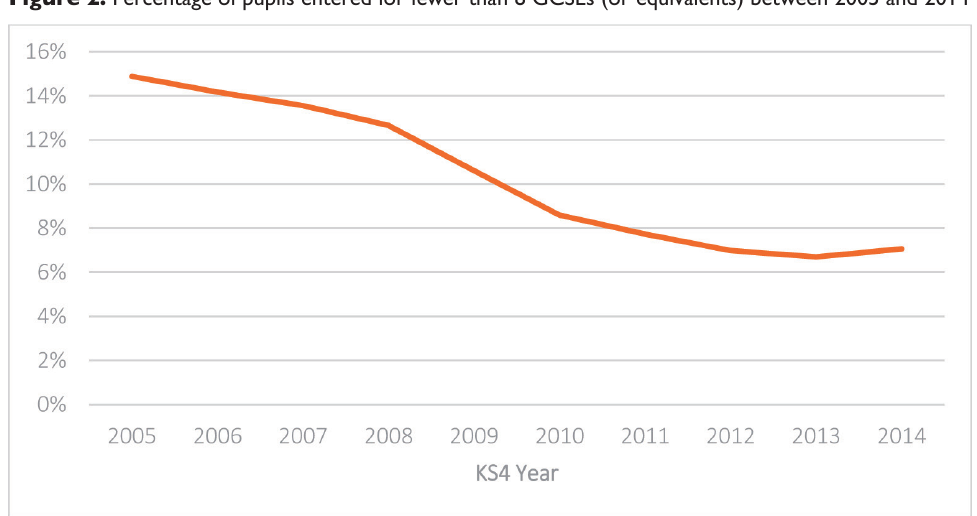
Figure 2: Percentage of pupils entered for fewer than 8 GCSEs (or equivalents) between 2005 and